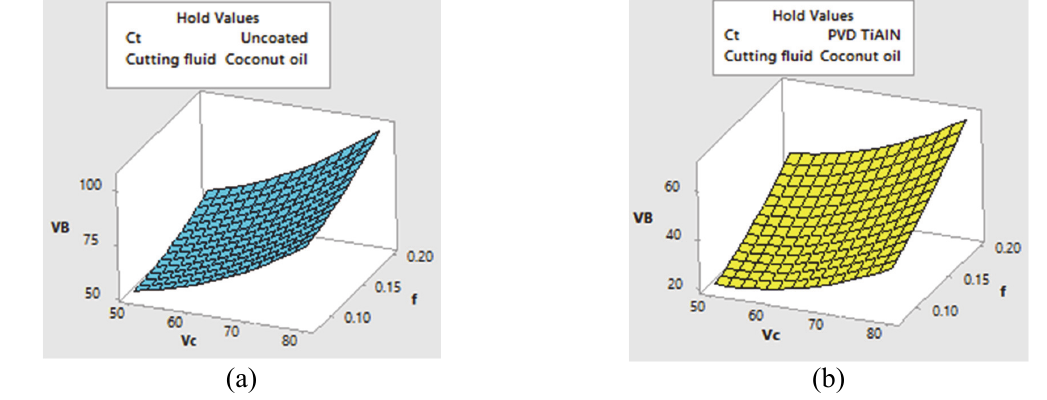
Fig. 12. Surface plot of VB in MQL enivironment (Coconut oil ) (a) Unoated (b) PVD TiAlN insert The normal probability plots of the residuals and the plots of the residuals versus the predicted response for the flank wear values are shown in Fig. 13. It reveales that the residuals usually fall on a straight line indicating that the errors are distributed normally.